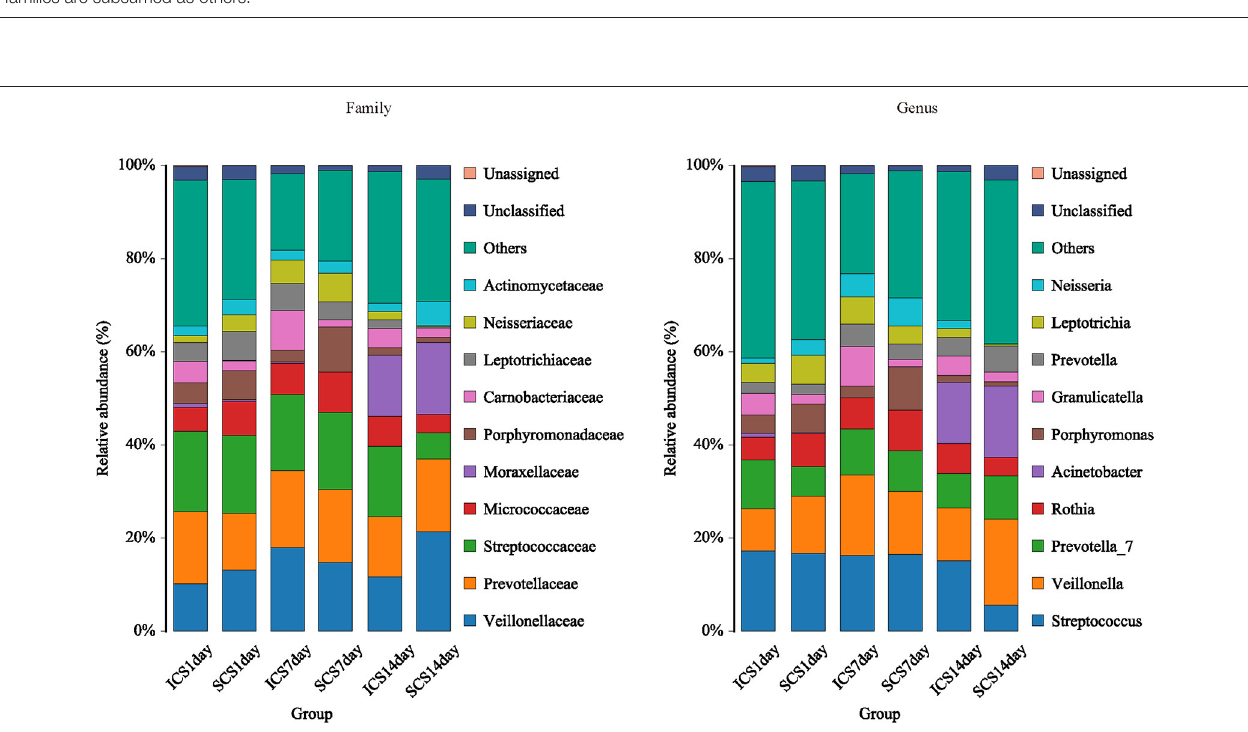
FIGURE 2 | Species distribution of each sample. Species distribution of bacteria in each sample (family and genus level). Community composition based on 16S rRNA gene fragment sequences in sputum samples. Bars represent the relative abundance of the most abundant families ( > 5% in one sample). The remaining families are subsumed as others.